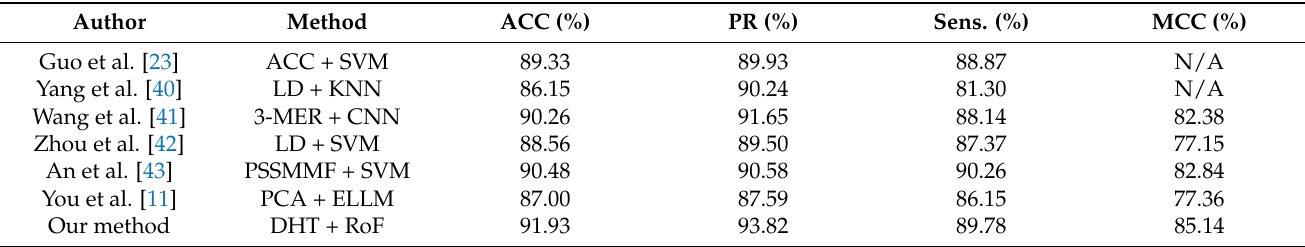
Table 6. Performance comparisons of computational methods on the Yeast